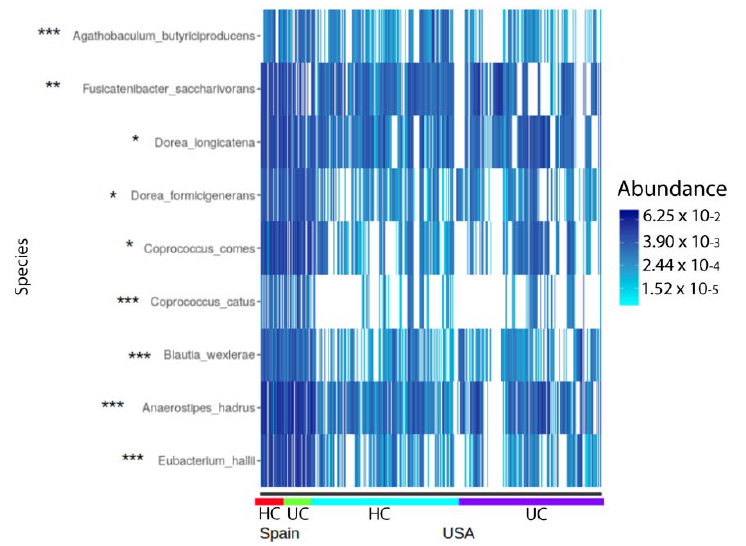
Figure 6. Common differentially abundant (DA) species between Spanish and USA cohorts in the HC and UC groups. * DA in both HC and UC. ** DA only in HC. *** DA only in UC. To reveal bacterial species associated with relapse or remission status in CD and UC, we split the CD and UC cohorts into two groups. The remission state consisted of 444 CD samples with HBI < 4 and 295 UC samples with CAI < 4 and the relapse state encompassed 119 CD samples with HBI ≥ 4 and 89 UC samples with CAI ≥ 4. In neither the CD nor UC group did disease activity status associate with specific bacterial species using